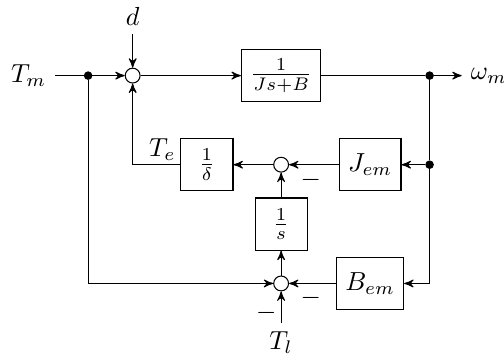
Figure 3. Proposed method to determine the torque of a dynamometer ( T e ) for the dynamic emulation of (3b).